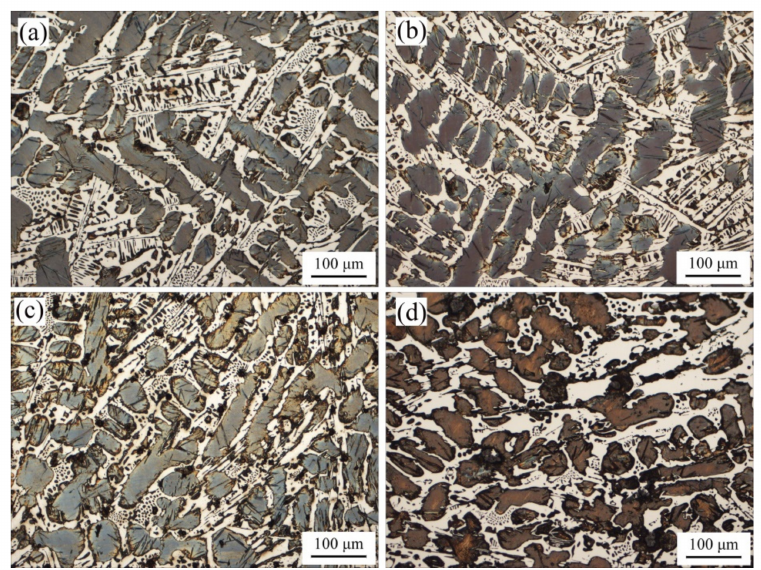
Figure 1. Metallographic images of the as-cast ICCI: ( a ) (NbTi)C-free; ( b ) 0.15 wt %; ( c ) 0.30 wt %; ( d ) 0.80 wt